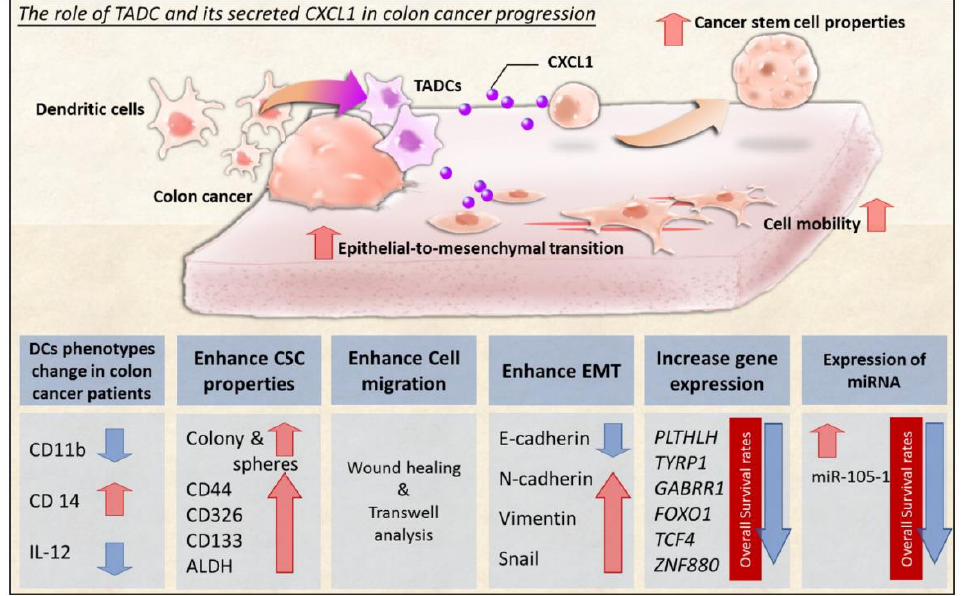
Figure 7. Proposed model of TADCs in colon cancer. Soluble factors in colon cancer cause abnormal phenotypes of dendritic cells, which in turn increase cancer stem cell properties, cell mobility, and EMT of colon cancer by producing the inflammatory chemokine CXCL1. Transcriptome analysis indicates that CXCL1 increases potential oncogene expression in colon cancer, including PTHLH , TYRP1 , FOXO1 , TCF4 , ZNF880 and the onco-miR miR-105. Our study indicates a new mechanism by which the colon cancer milieu exploits DC plasticity to support cancer progression.